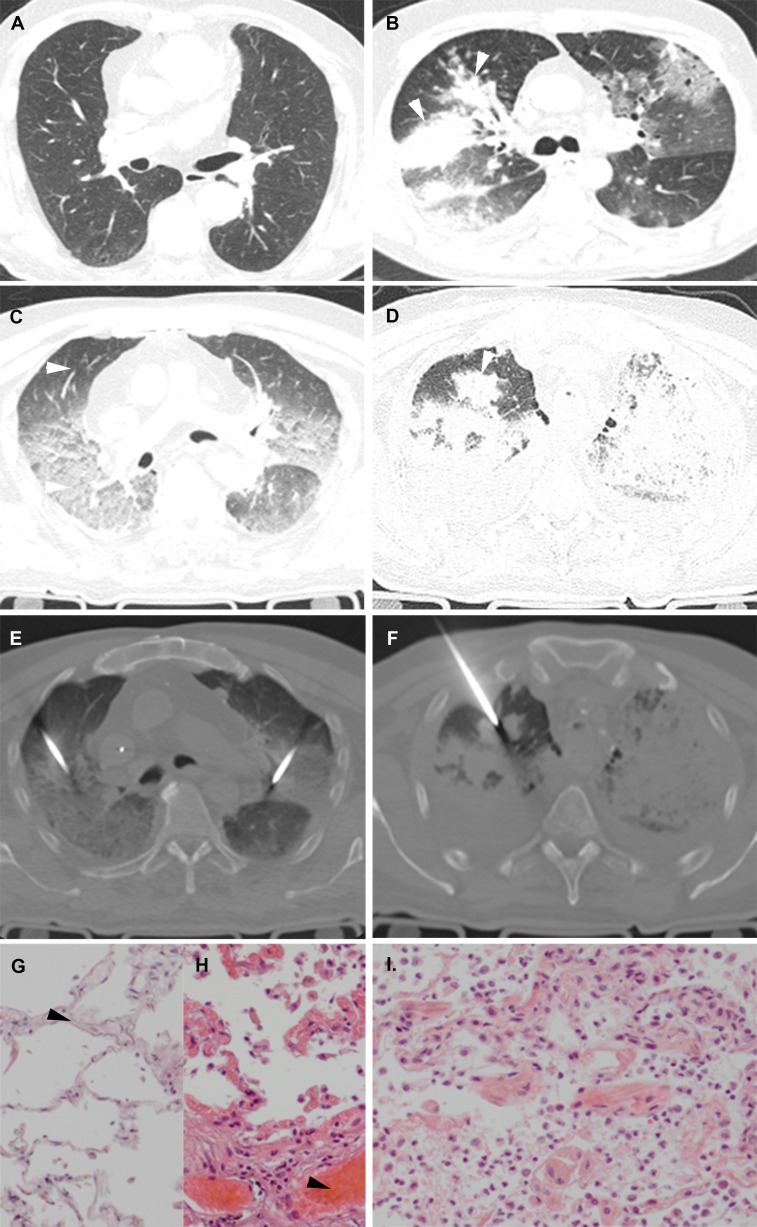
Internal livores of the lungs versus pneumonia.(A/C) antemortem CT (A) and PMCT (C). Normal (A) and internal livores (C) (arrowheads). (B/D) antemortem CT (B) and PMCT (D). Patient with a pneumonia (arrowheads). (E) CT-guided lung biopsies in the same patient as A/C. (F) CT-guided lung biopsy in the same patient as B/D. (G) HE, x100 original magnification. Lung parenchyma non-dependent: capillaries in alveolar walls practically devoid of blood (arrowhead). (H) HE, x100 original magnification. Same patient as G, lung parenchyma dependent, capillaries in alveolar walls congested with blood (arrowhead). (I) HE, x100 original magnification. Same patient as B/D/F, lung parenchyma, resolving pneumonia with thickened alveolar walls with mainly lymphocytic infiltrates, and hyaline membranes and extravasations of erythrocytes in the alveolar spaces.